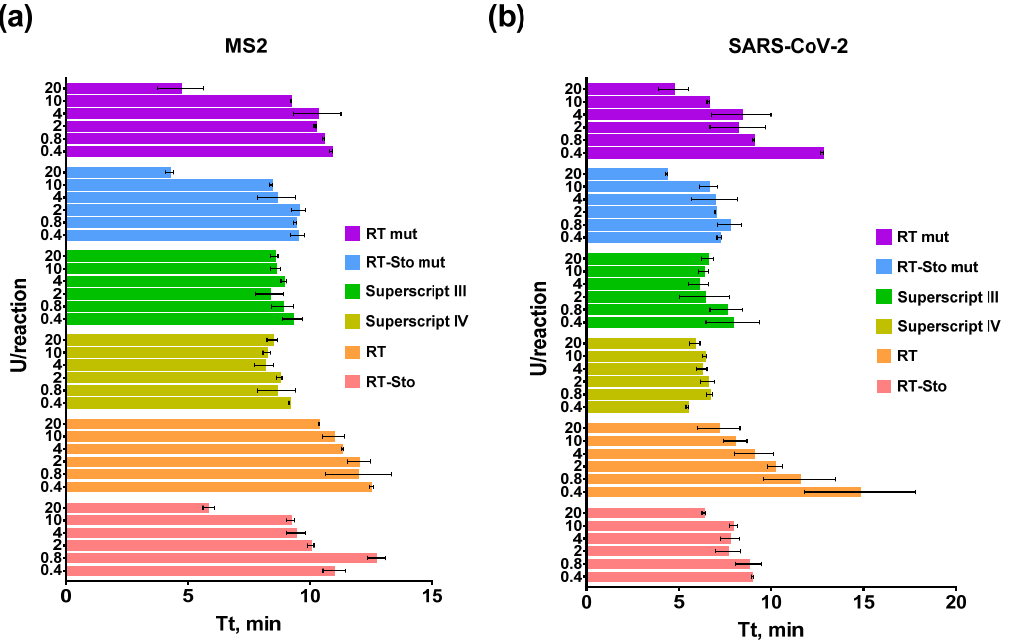
Figure 1. RT-LAMP with various amounts of RTs and primers for MS2 ( a ) and SARS-CoV-2 ( b ). The temperature of the reverse transcription step was 42 ◦ C. Each enzyme is marked by the color specified in the legend. SARS-CoV-2 RNA fragment and MS2 genomic RNA were added in reactions to a final concentration of 10 3 copies per reaction. The time-to-threshold (Tt) values are presented on the X-axis, and the number of enzyme units per reaction is on the Y-axis. Each experiment was triplicated, with error bars representing one SD.